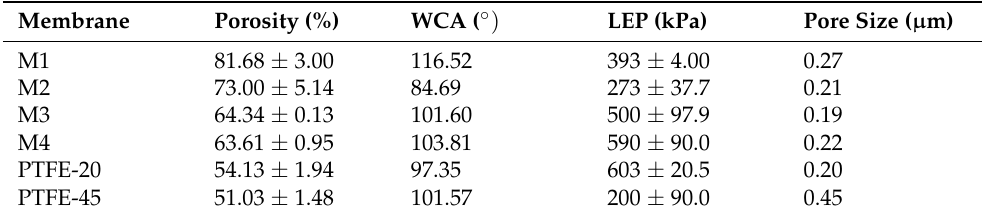
Table 2. Physical characteristics of the as-synthesised PVDF and PTFE membranes. Membrane